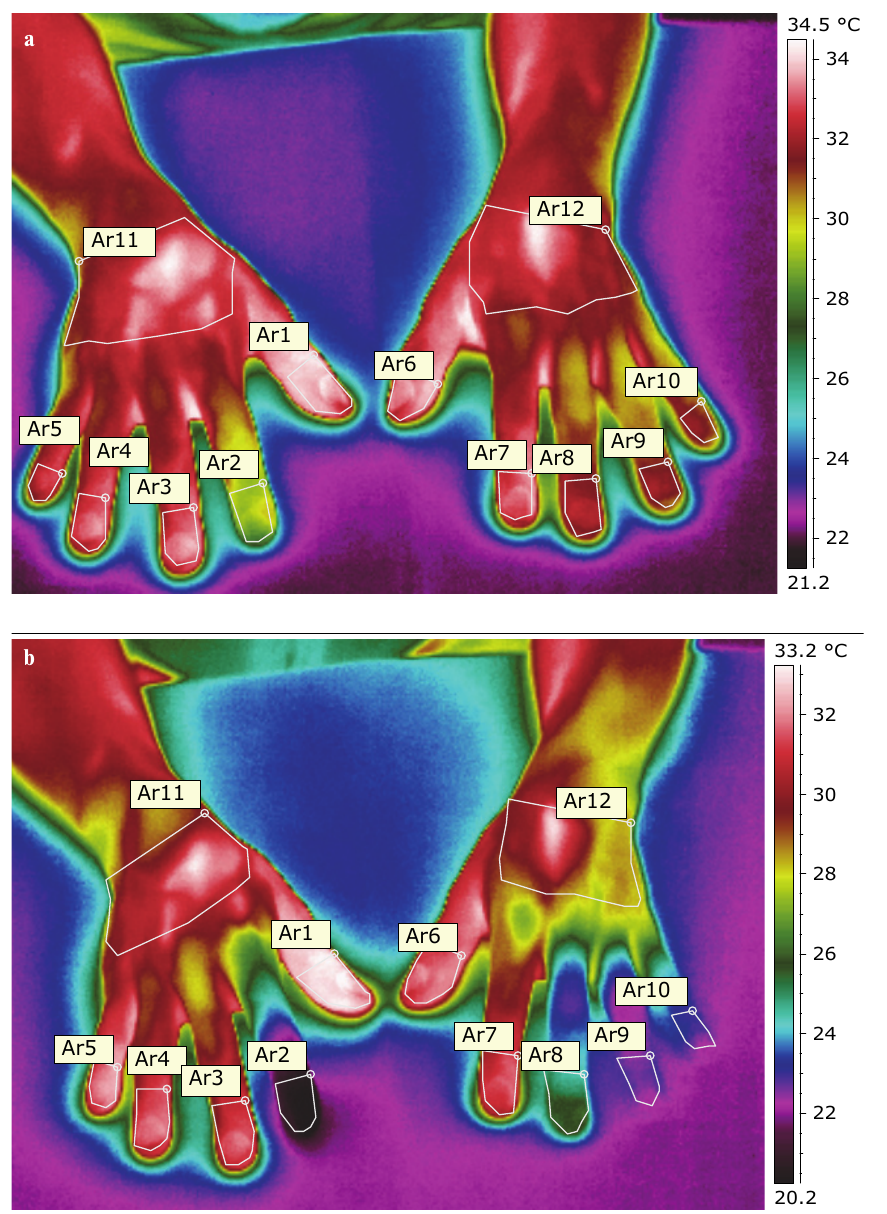
Fig. 2. RP finding during IRT examination. 2a. Thermogram before CPT. No evidence of acral perfusion disorder – all fingers had a temperature > 29